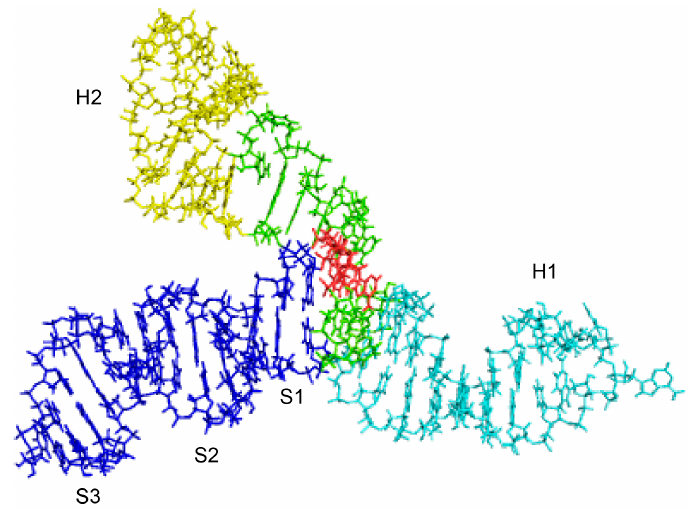
Figure 10. A 3D structure model of Ty1i RNA domain I. Structural elements are annotated: hairpin H1 (cyan), hairpin H2 (yellow), stem S1–3 (blue) and 3 ‐ way junction (green). AUG1 sequence is (cyan), hairpin H2 (yellow), stem S1–3 (blue) and 3-way junction (green). AUG1 sequence is marked marked in red. in